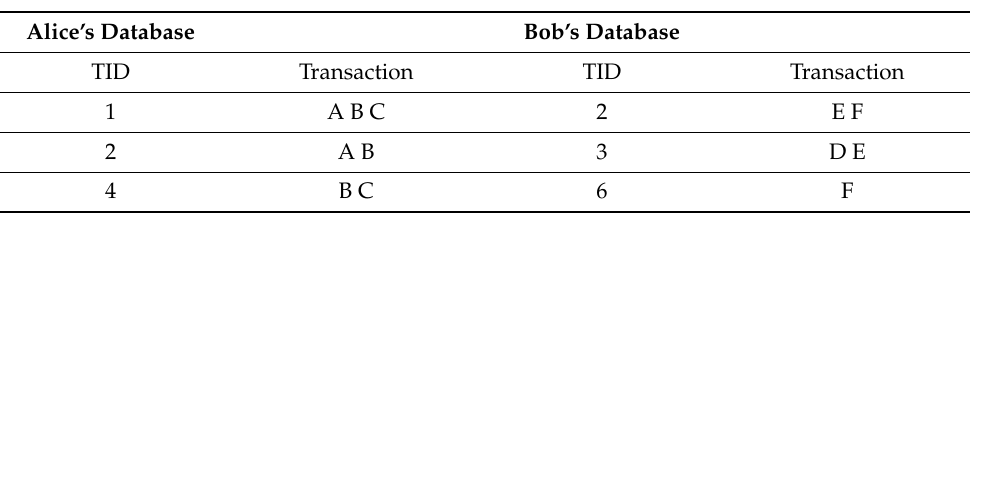
Table 2. Data Owners’ Transaction